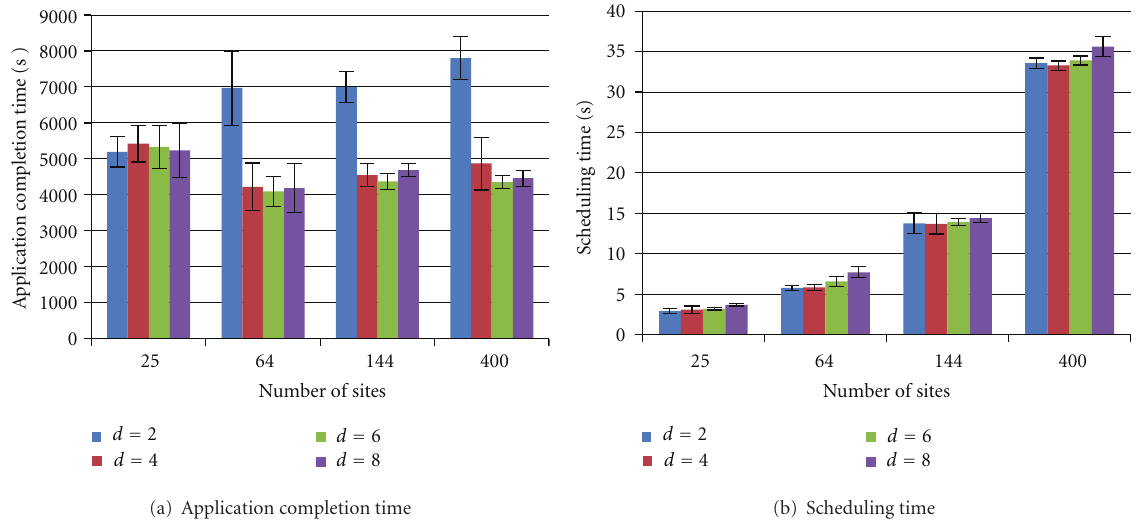
Figure 4: E ff ect of average node degree for di ff erent network